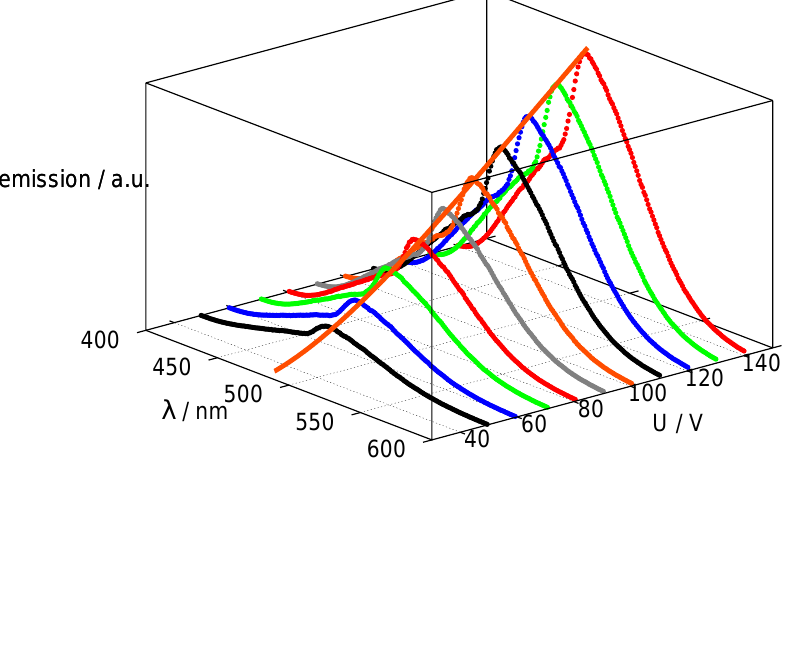
Figure 5 . Emission spectra of conventional AC-El cell at various driving voltages, frequency: 300 Hz.